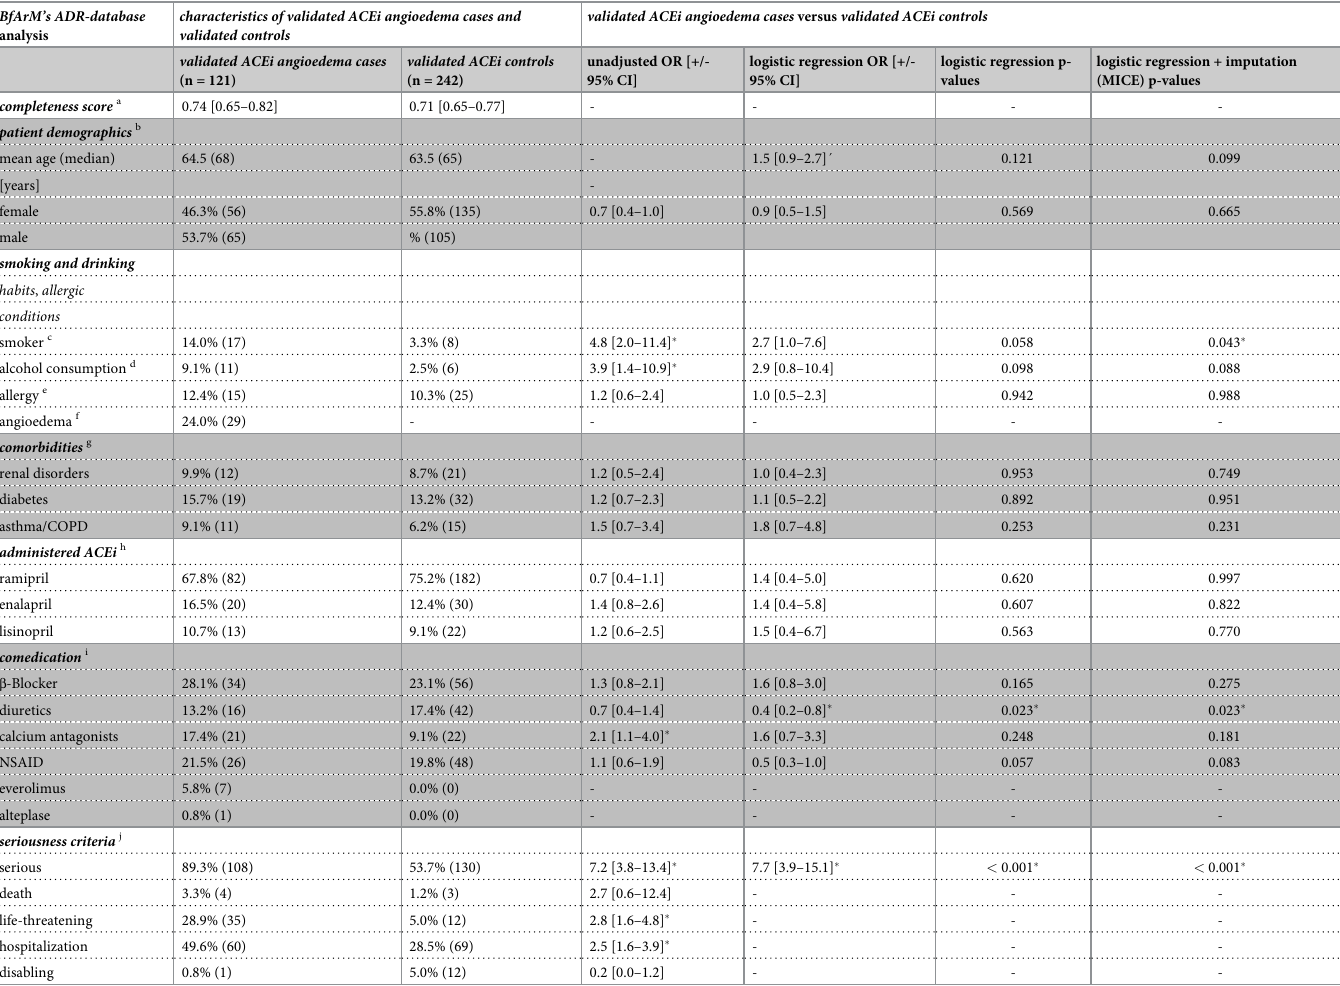
Table 2. BfArM’s ADR-database analysis: Characteristics of validated ACEi angioedema cases and validated ACEi controls . BfArM’sADR-database